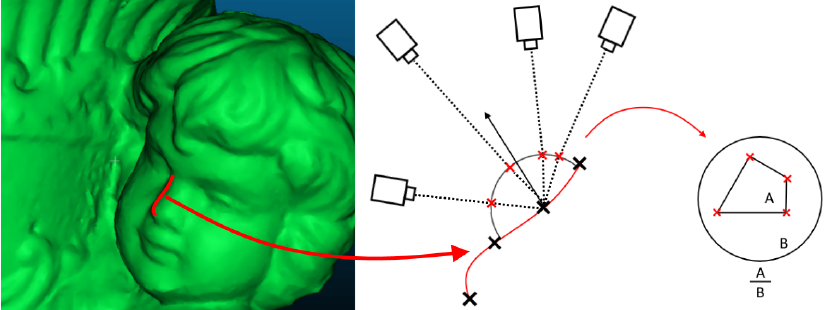
Figure 6. Visualization of the calculated hemisphere positioned above each vertex in the mesh and the camera position, together with the intersection points. The distance from the camera to the vertex position is made in a smaller scale for easier visualization. Once all the intersection points are found the area between them is calculated and the ratio between it and the whole area is used for the